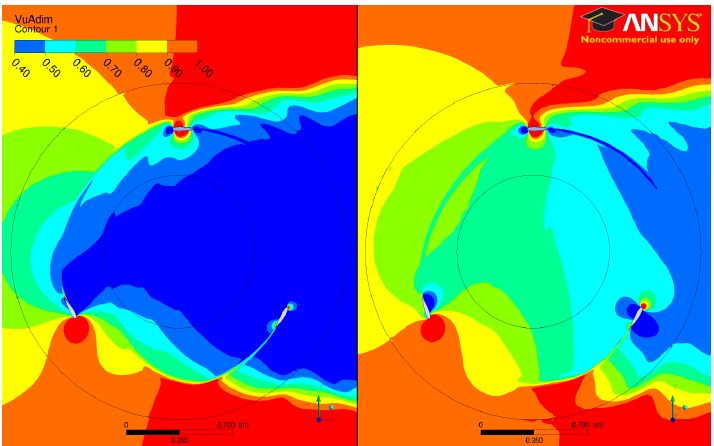
Figure 14. Isocontours of non-dimensioned streamwise velocity ( U x / U ∞ ) for the Darrieus ( left ) and the PL2 ( right ) cases, λ = 3. Instantaneous flow field with blade 1 located at θ = 0 ◦ .